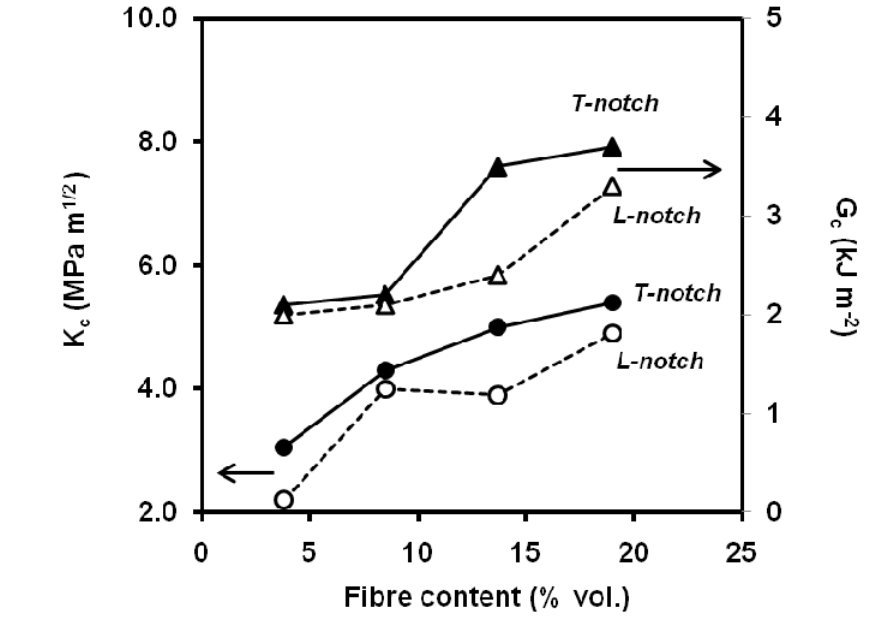
values for injected-moulded PP Ic